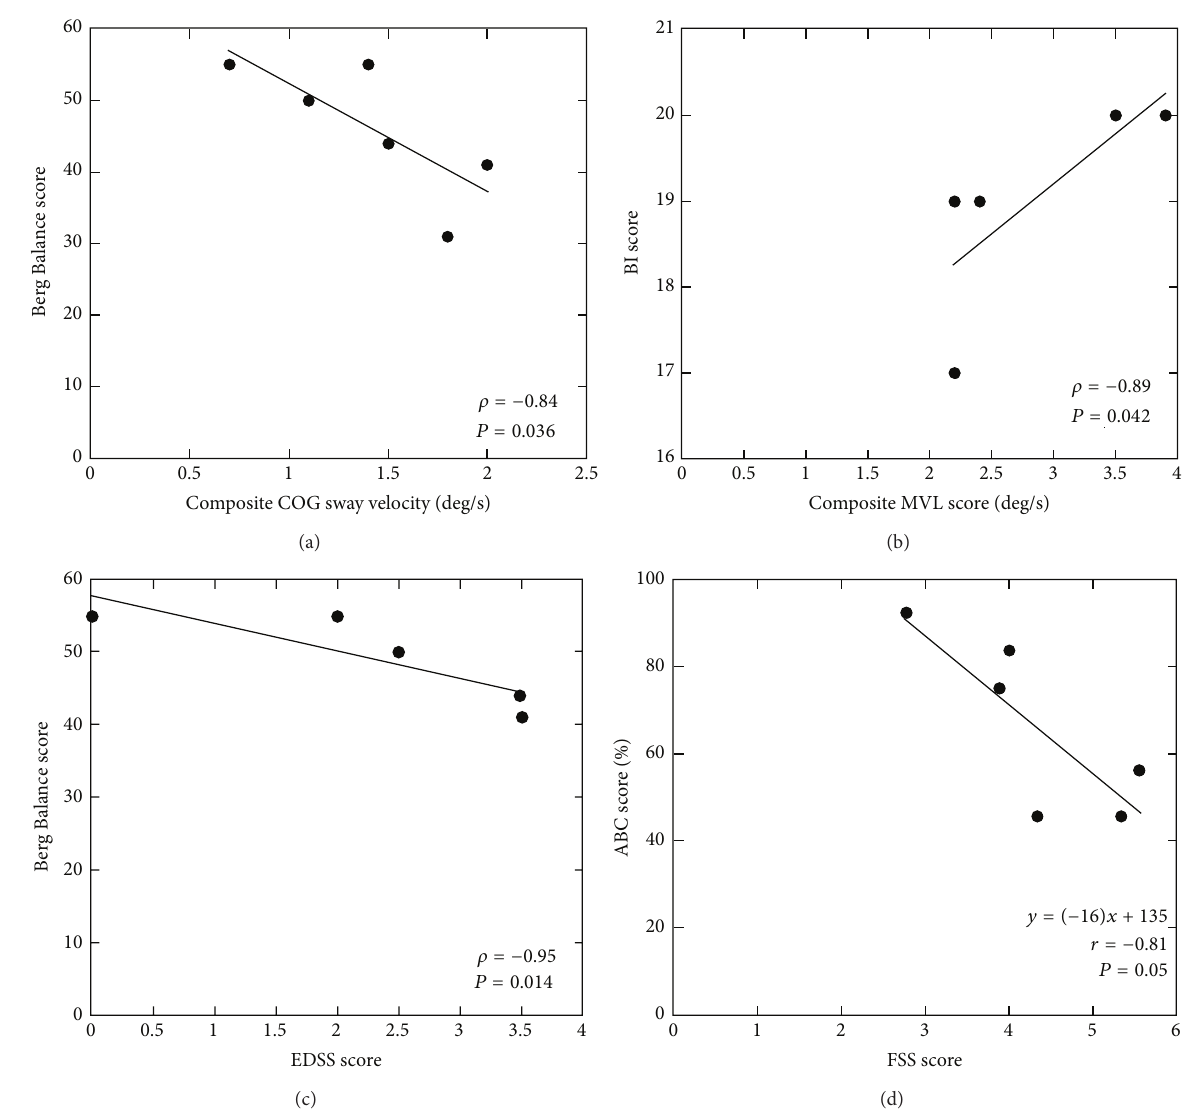
Figure 4: The results of correlation and regression analysis between clinical and instrumented outcome measures for the individuals with MS with a history of falls (MS-F). EDSS: Expanded Disability Status Scale. Other abbreviations as defined in Figures 1 and 2 captions. All correlations and regression analyses shown are statistically significant ( 𝑃 < 0.05